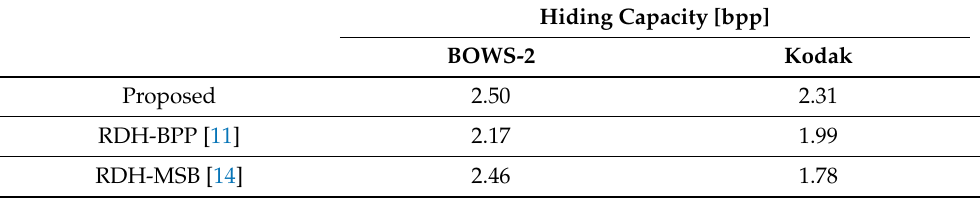
Figure 9. Evaluation results through experiments. Table 1. Average hiding